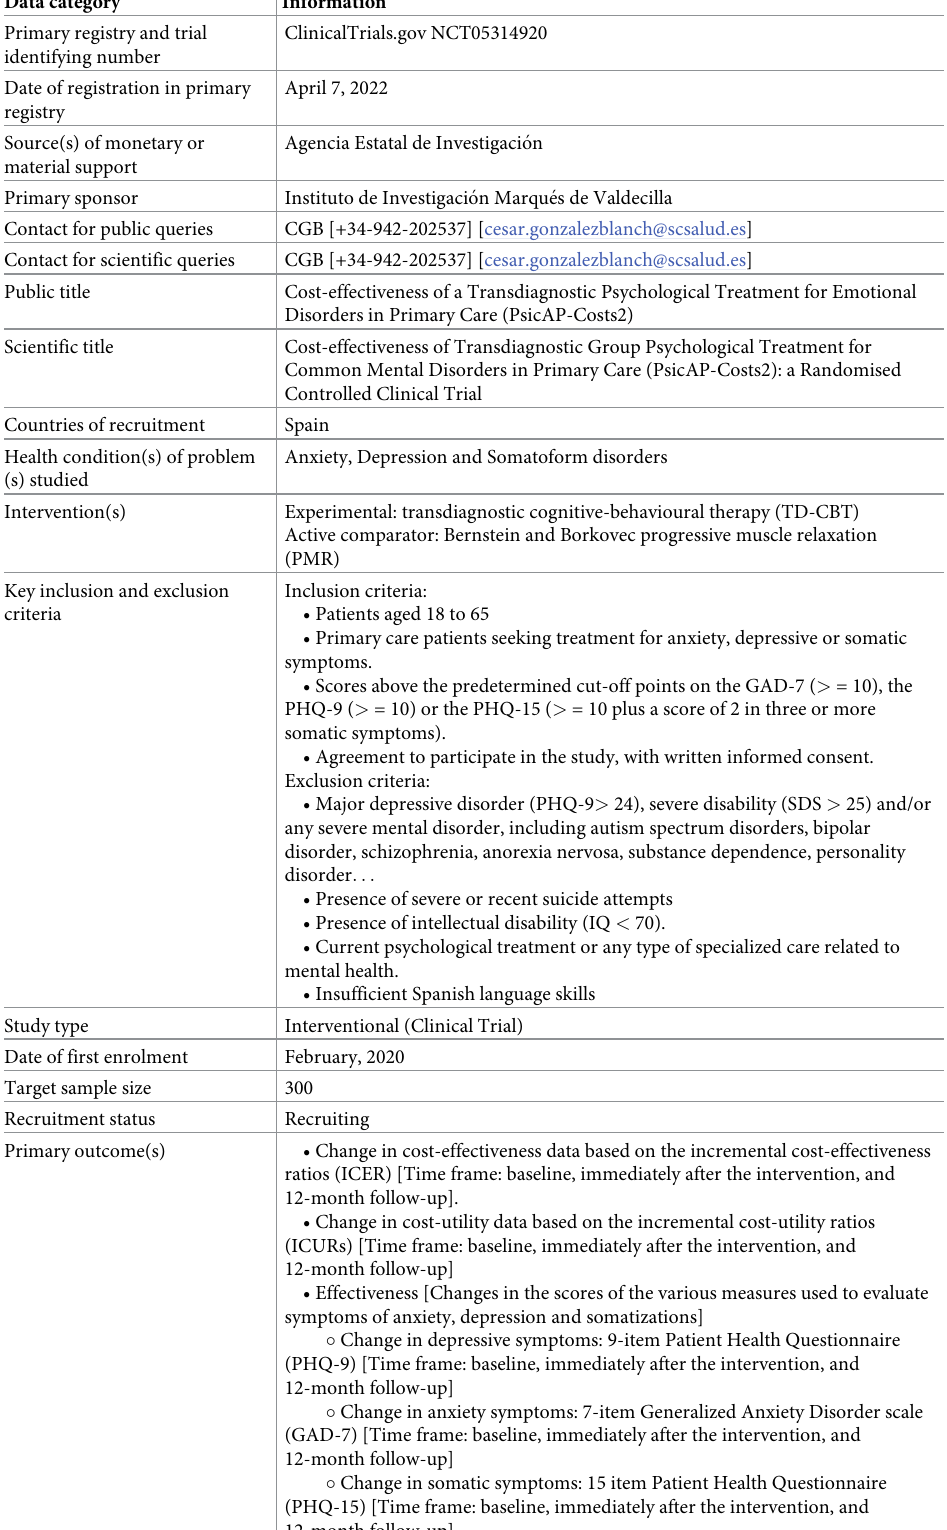
Table 1. Items from the World Health Organization trial registration data